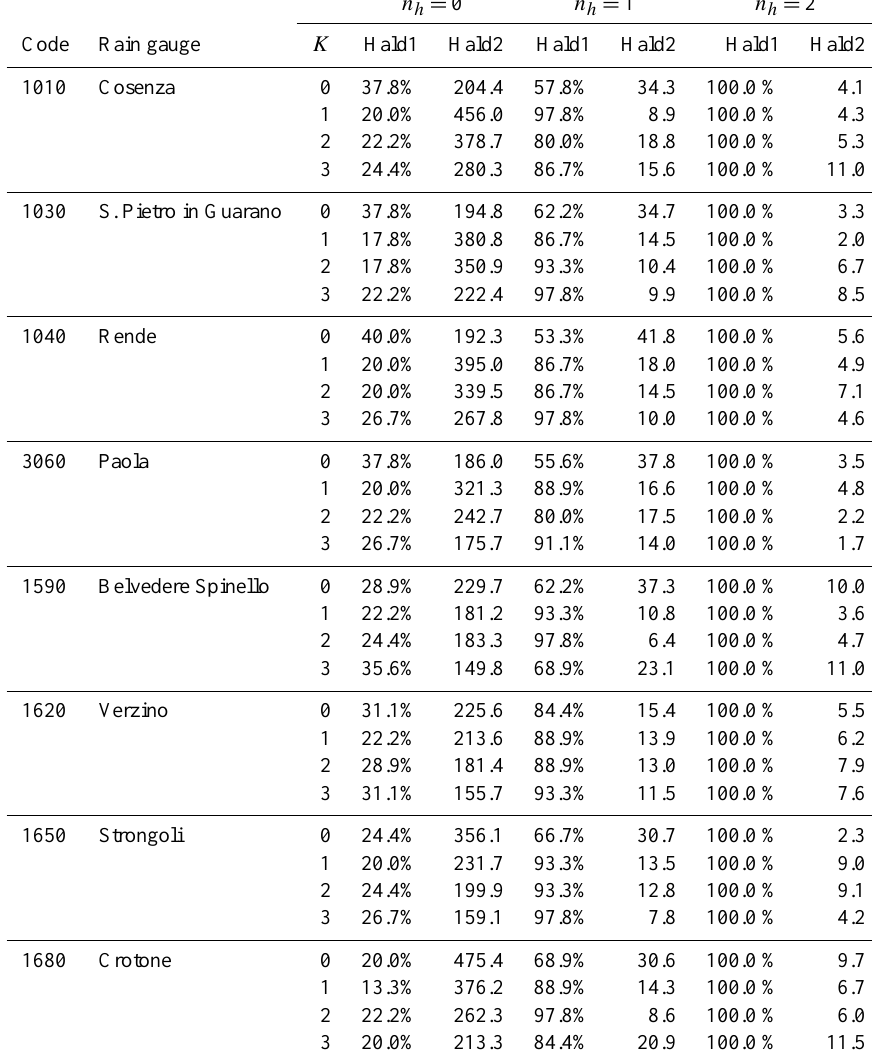
Table A1. Results from the application of Hald